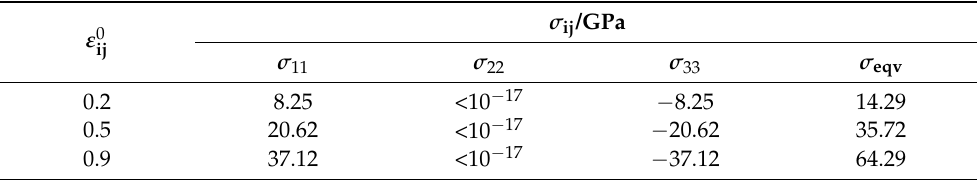
= − ε 0 = 0.2, 0.5 and 0.9, and ε 0 = 0). Von Mises 33 22 11